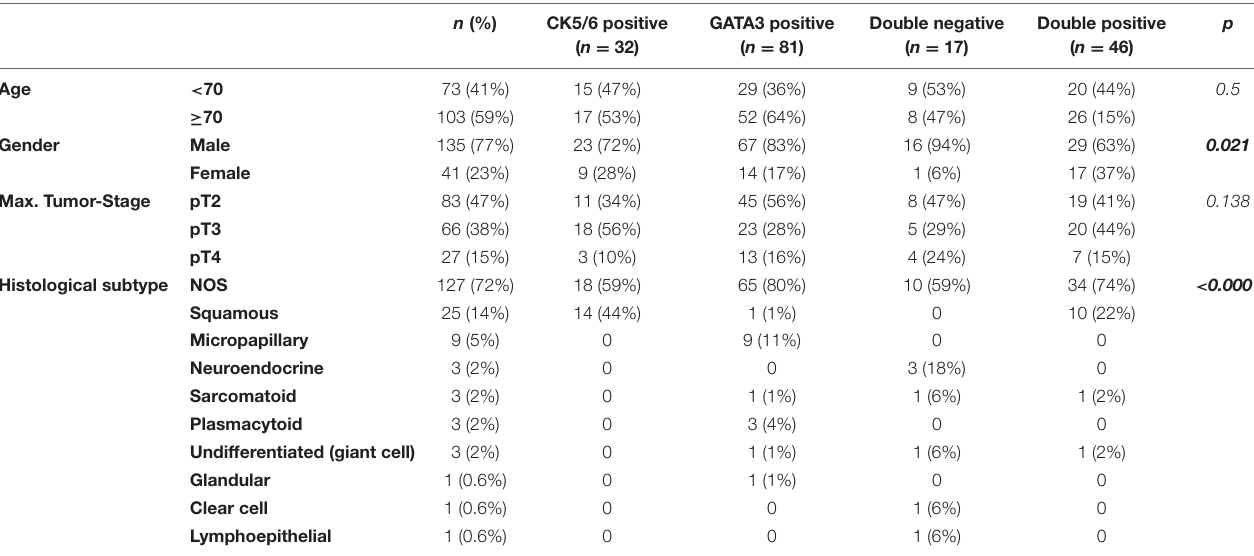
FIGURE 1 | Representative images of IHC staining of CK5/6 positive, GATA 3 positive, double negative, and double positive cases (magnification 200 × ). TABLE 2 | Association of clinic-pathological findings with the IHC-markers CK5/6 and